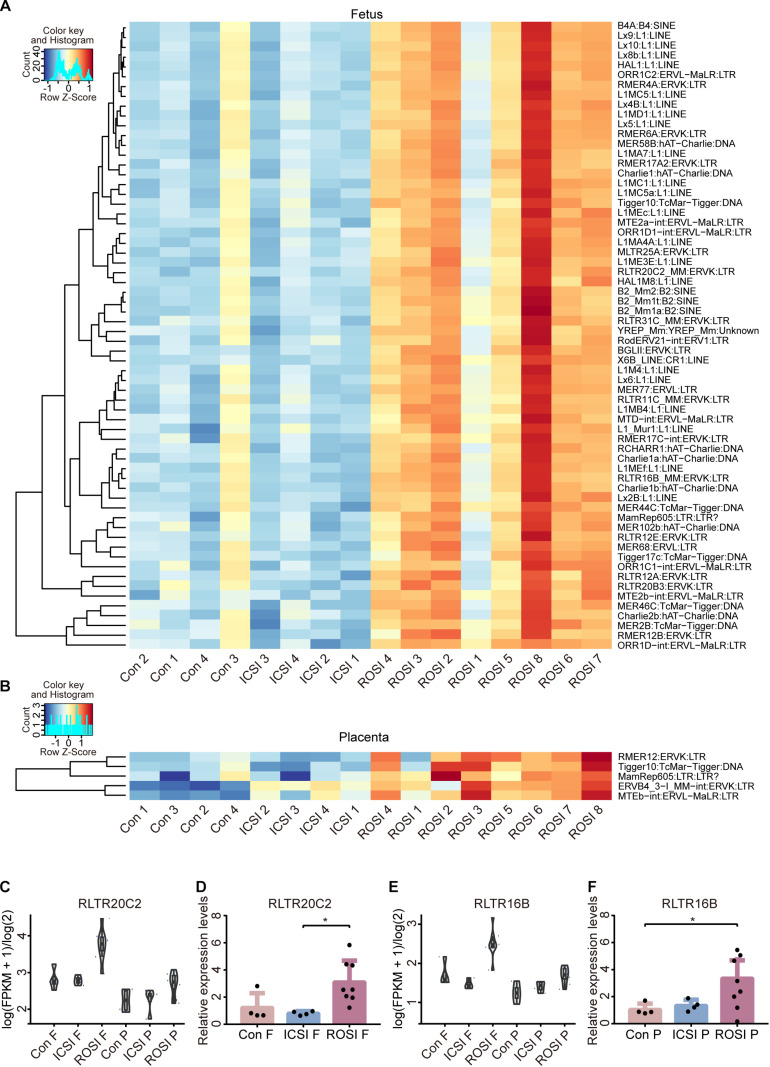
Repetitive DNA sequence expression in ROSI-derived fetuses and placentas. (A) Heatmap of RS expression in fetuses. (B) Heatmap of RS expression in placentas. (C) RNA-seq depicting RS RLTR20C2 expression in fetuses. (D) qRT-PCR depicting the expression of RS RLTR20C2 in fetuses. (E) RNA-seq depicting RS RLTR16B expression in placentas. (F) qRT-PCR depicting the expression of RS RLTR16B in placentas. *, P < 0.05; LINEs, long interspersed nuclear elements; SINEs, short interspersed nuclear elements; LTRs, long terminal repeats; Con, Control; F, Fetus; P, Placenta; RS, repetitive DNA sequence.